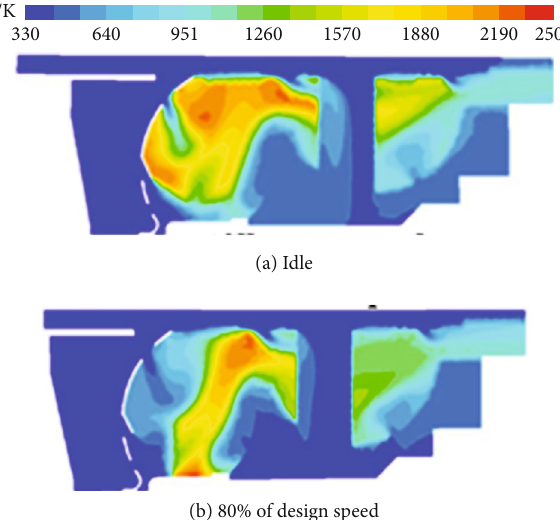
Figure 7: Distribution of temperatures at two working conditions.